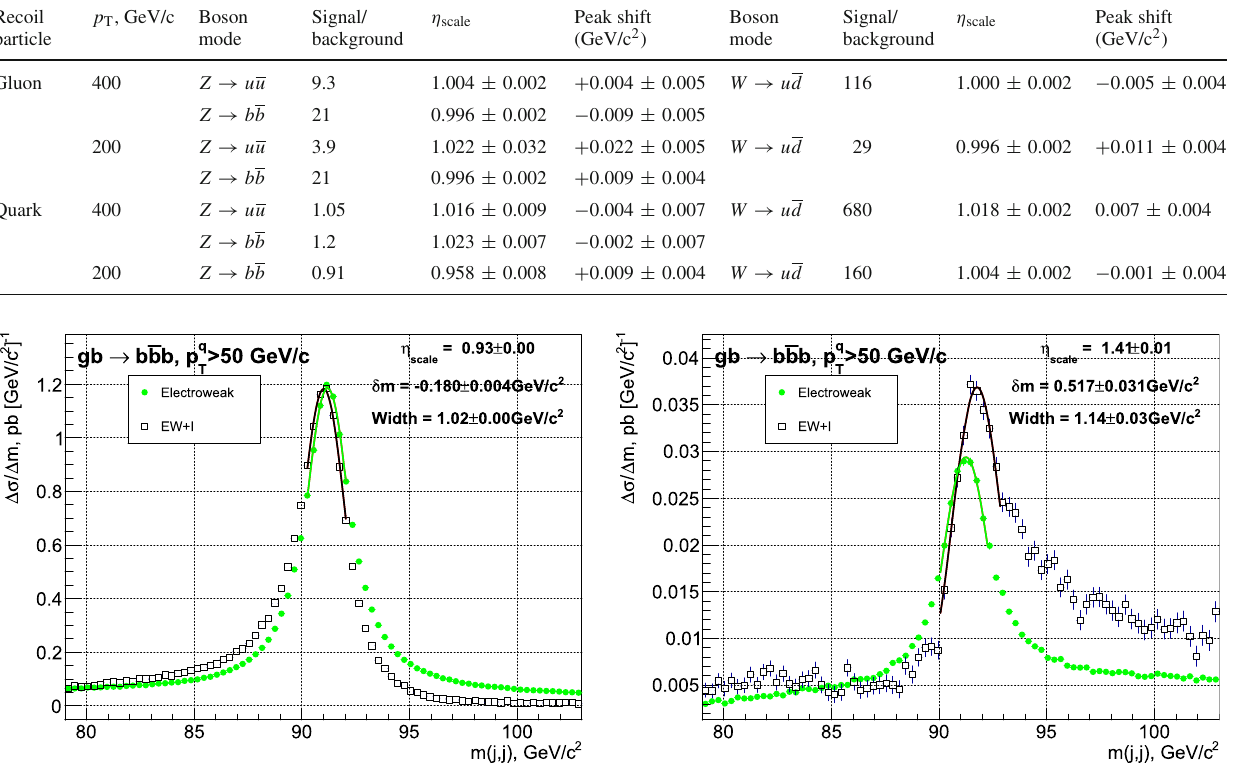
Fig. 7 The process bg → b bb . Left shows events where | (cid:10)η | < 1 between the Z candidate quarks, while right requires | (cid:10)η | > 2. Each event generates two bb combinations and two entries in these plots if they both fall within the mass range